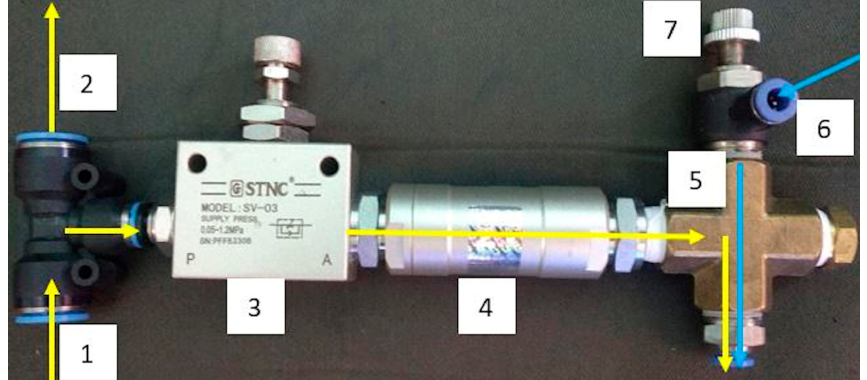
Figure 4. MQL valve circuit. (1) oil inlet; (2) return hose; (3) regulating valve; (4) check valve; (5) hydraulic equal cross coupling—air + oil mixture; (6) inlet compressed air; (7) control valve for compressed air.